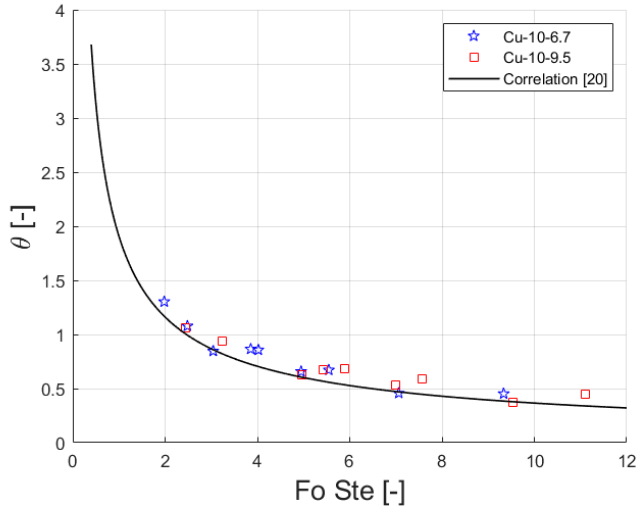
Figure 9. Dimensionless temperature versus product Fourier and Stefan numbers. Experimental values and predicted curve [20].